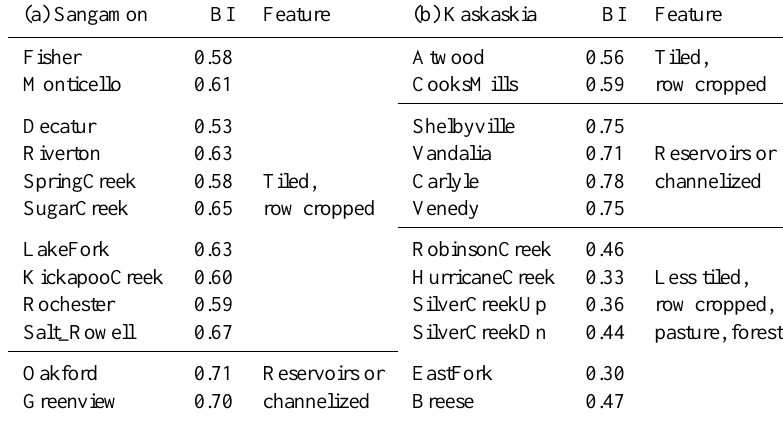
Table 2. Baseflow Index values for 1990–2011 and associated catchment features for (a) Sangamon and (b) Kaskaskia. (a) Sangamon